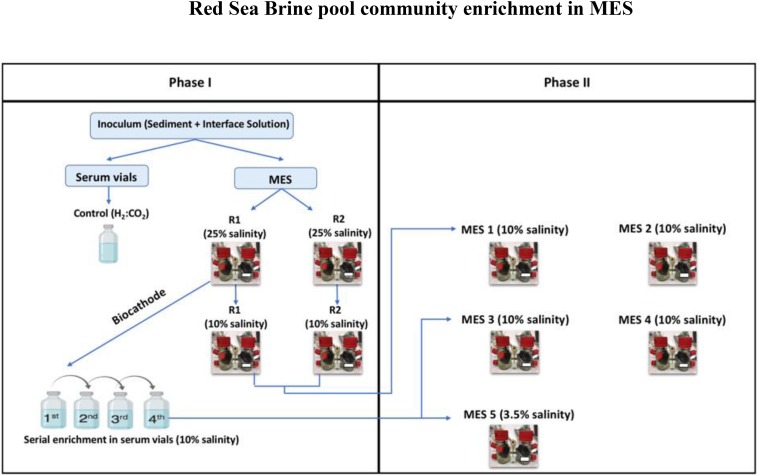
Illustration showing the different enrichment phases.